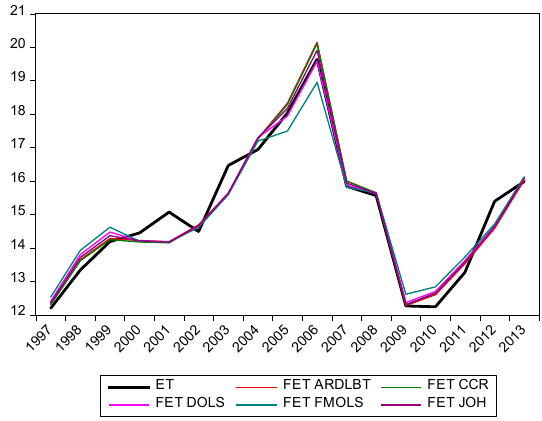
Figure 3. Actual and forecast (in sample) electricity demand, TWh. Table 10. Forecast statistics of Error Correction Models.